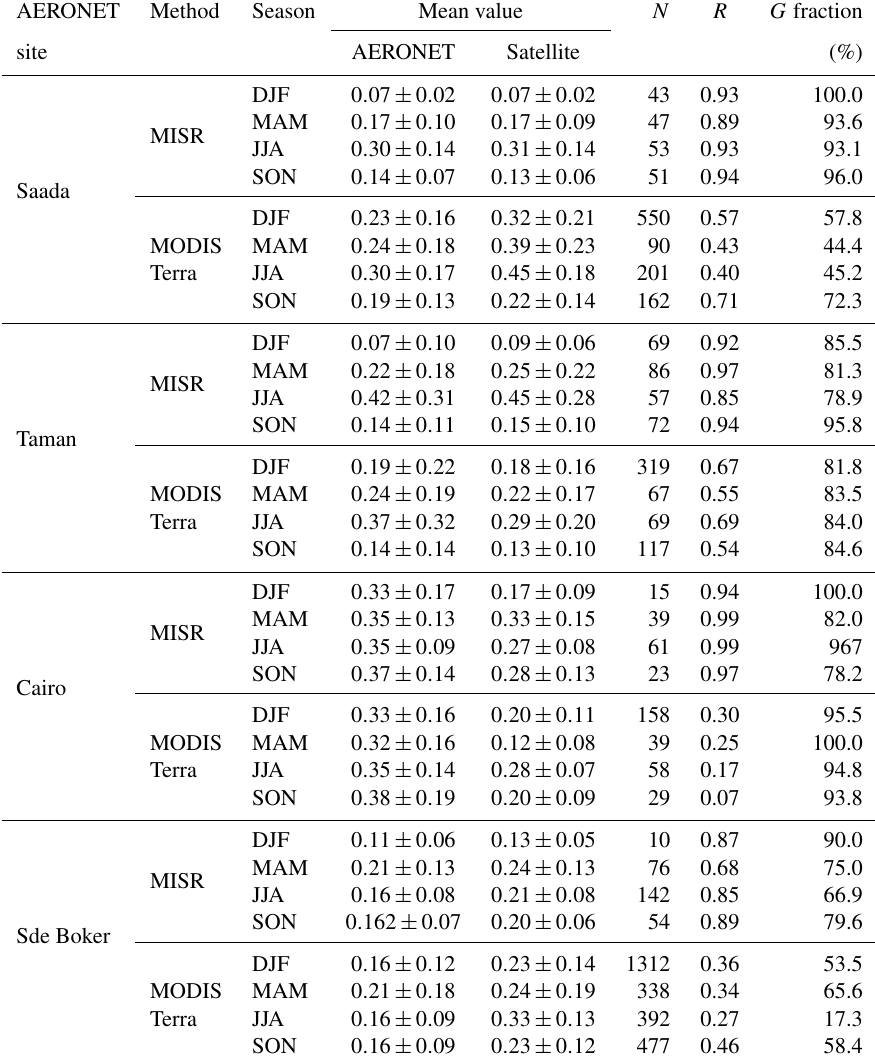
Table 3. Statistics for biomass and mixed sites, parameters as in Table 2.